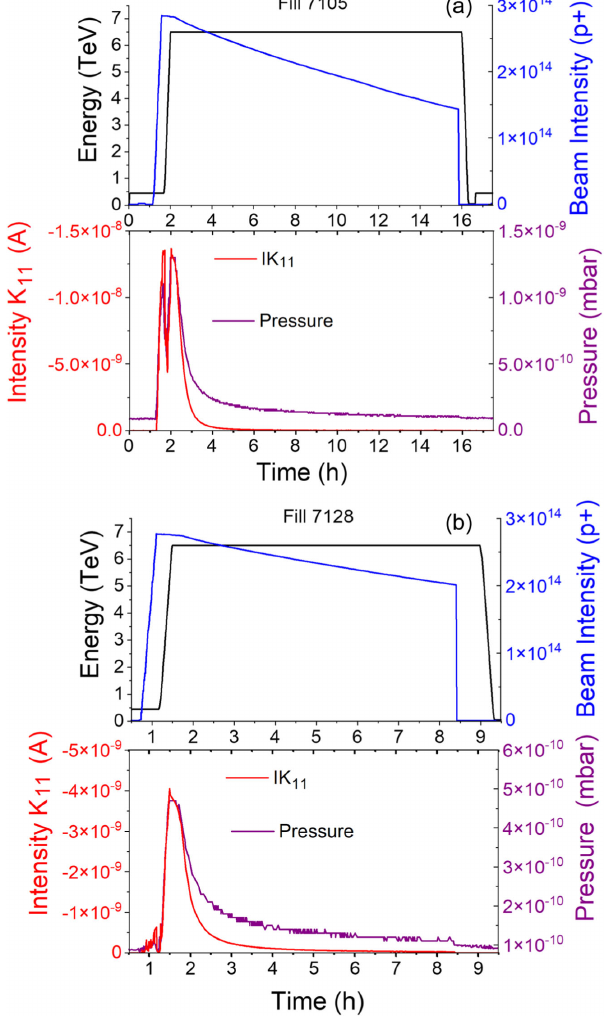
FIG. 3. Energy and intensity of beam 1 (top), electron current and pressure (bottom) during fills 7105 (a) and 7128 (b),